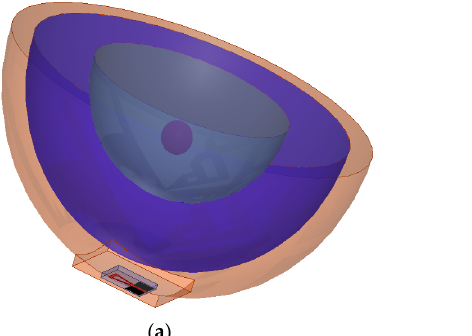
Figure 10, Breast with tumor models scanned using ( a ) one antenna and ( b ) two antennas.